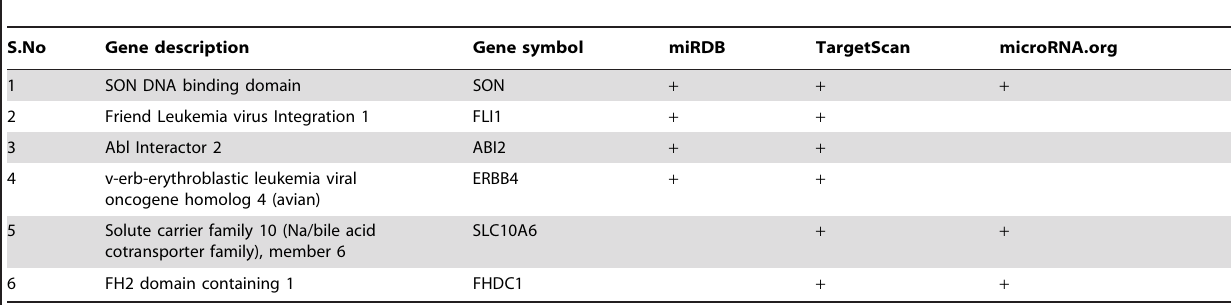
Table 1. Target prediction for miR-193a-3p using 3 different programs.